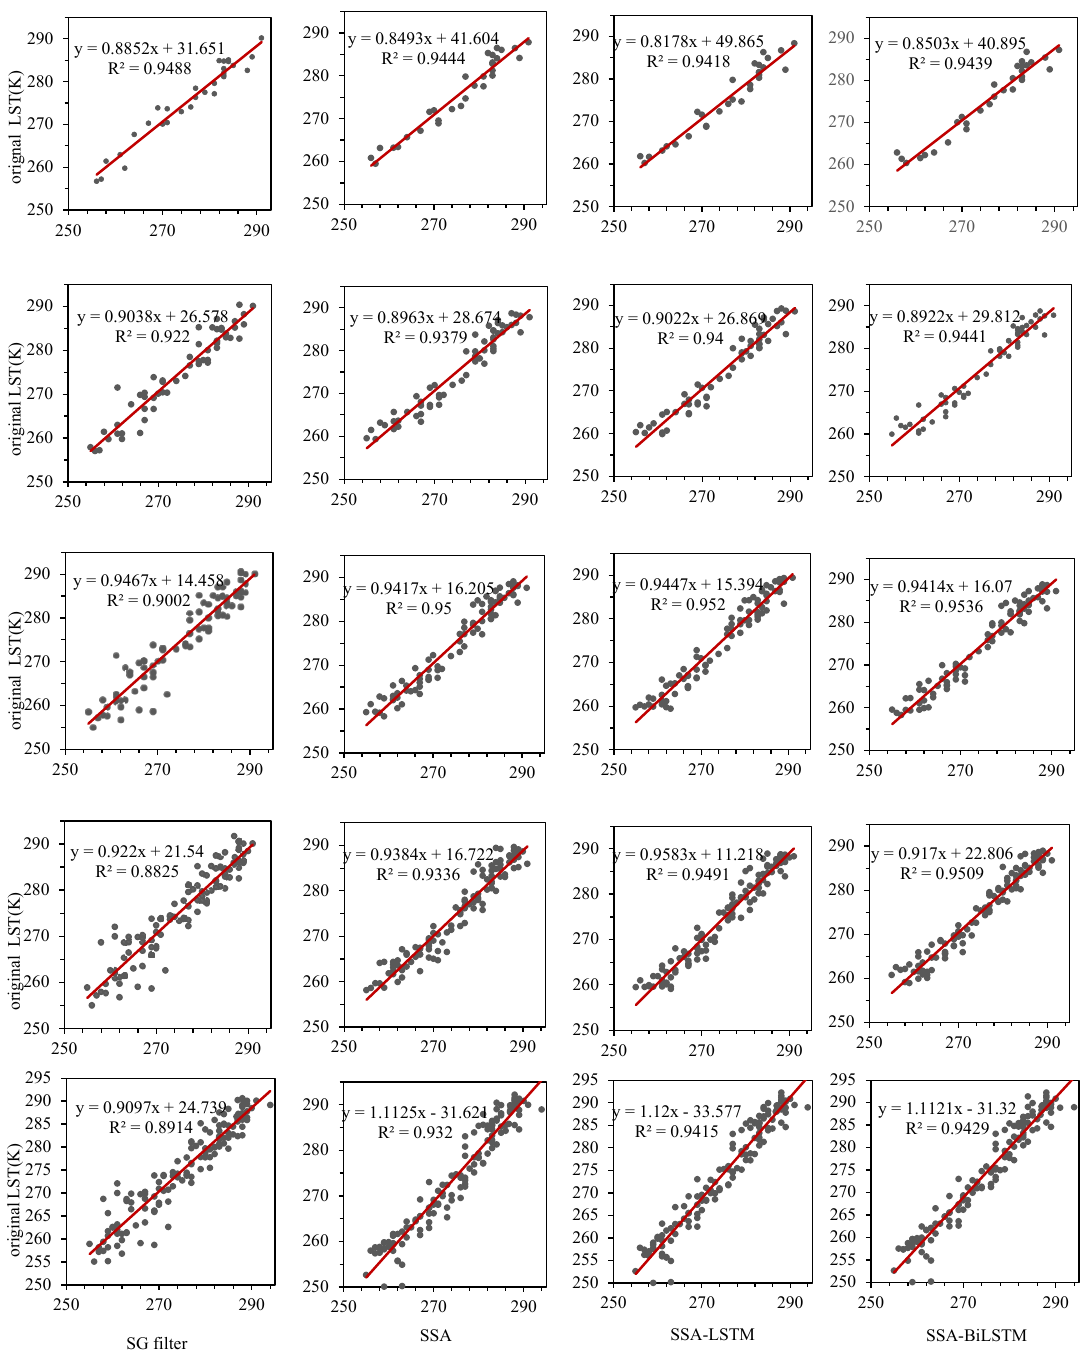
Figure 6. Comparative analysis of the correlation between LST data reconstructed with different methods and the original data at varying missing rates. The figures in lines 1 to 5 show the correlation analysis results of different LST reconstruction methods when the data missing rate is 10%, 20%, 30%, 40% and 50%, respectively.